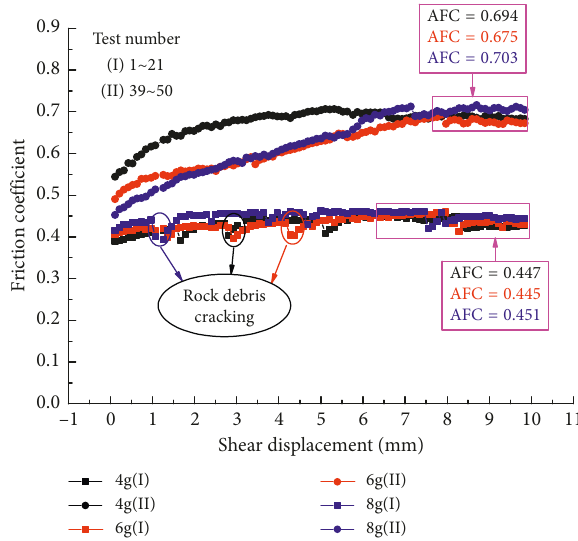
Figure 15: Direct shear testing results under a mixture of waste slurry, bentonite slurry, and